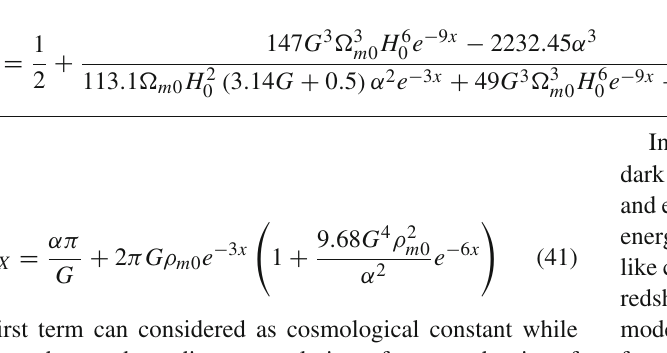
Substituting energy density and pressure of dark energy, Eqs. (41) and (42) when matter behaves like dust field into Eq. (44) yields deceleration parameter, namely